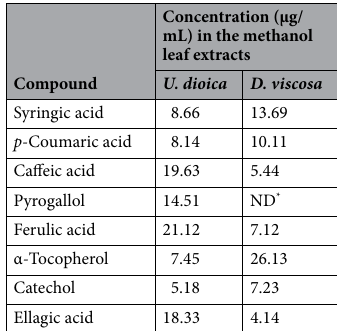
Table 3. Phenolic compounds identified in the leaf methanol extracts from U. dioica and D. viscosa by HPLC. *Not detected.